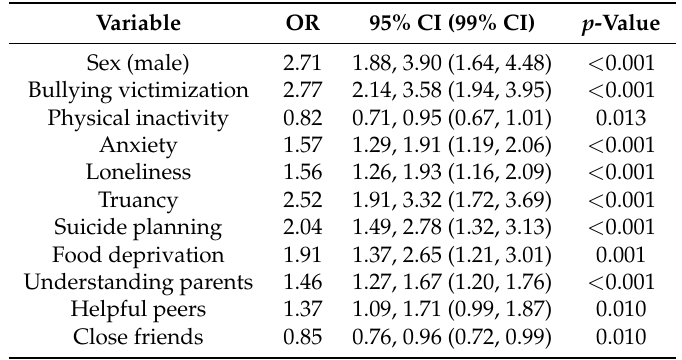
Table 5. Outcomes of multivariable analysis of variables associated with physical fighting attempts among school-attending adolescents in Kuwait, GSHS